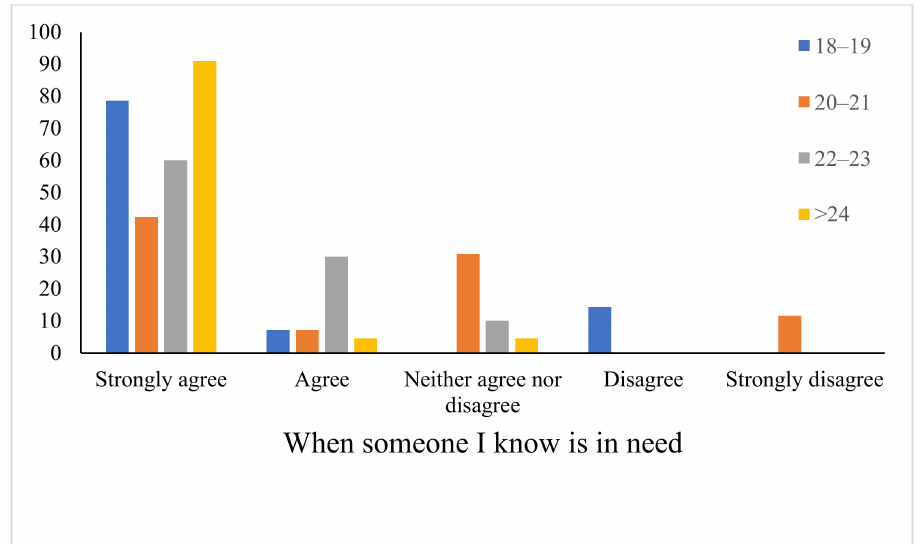
Figure 1. Association between age and blood donation motivators (When someone I know is in need) ( n = 72).